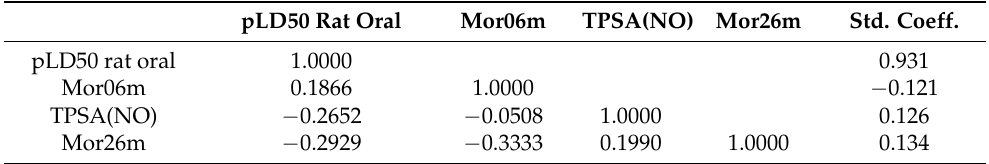
Figure 3. Williams plot predicted by the MLR1 model ( left ) and by the leave-one-out ( right ) cross-validation approach (yellow circles-training compounds, blue circles-test compounds). The selected descriptors included in the MLR1 best model are not intercorrelated, as presented in the correlation matrix from Table 5. Table 5. Correlation matrix of the descriptors included in the best MLR1 model, and their standard- ized coefficients (Std. coeff.).